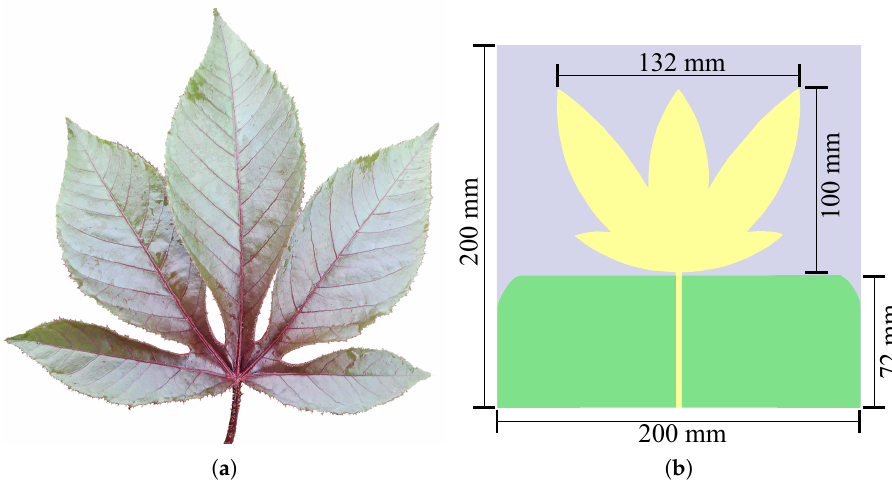
Figure 3. ( a ) Graphical representation of the Jatropha mollissima (Pohl) Baill leaf and ( b ) the designed bio-inspired antenna.